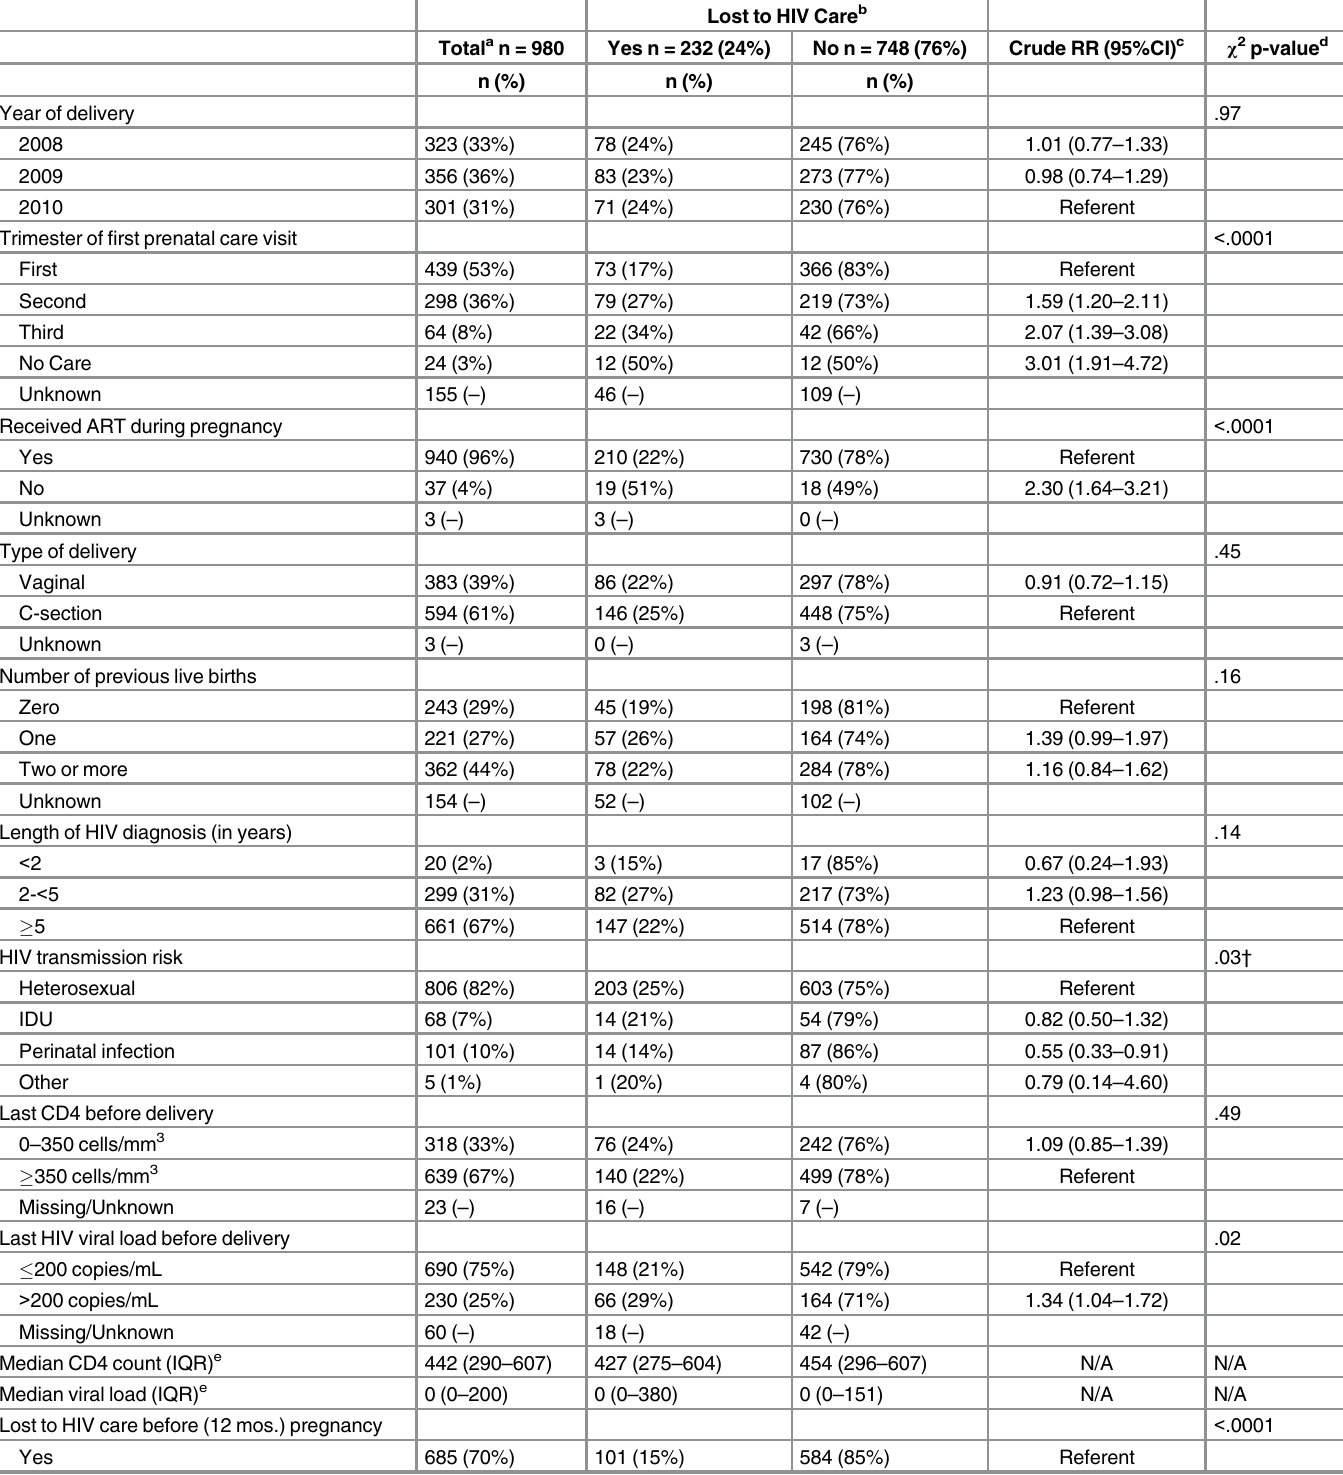
Table 2. Lost to HIV Care in the Postpartum Year among HIV-Infected Women with a Live Birth, Diagnosed Before Pregnancy, New York State, 2008 – 2010, Pregnancy-Related and HIV